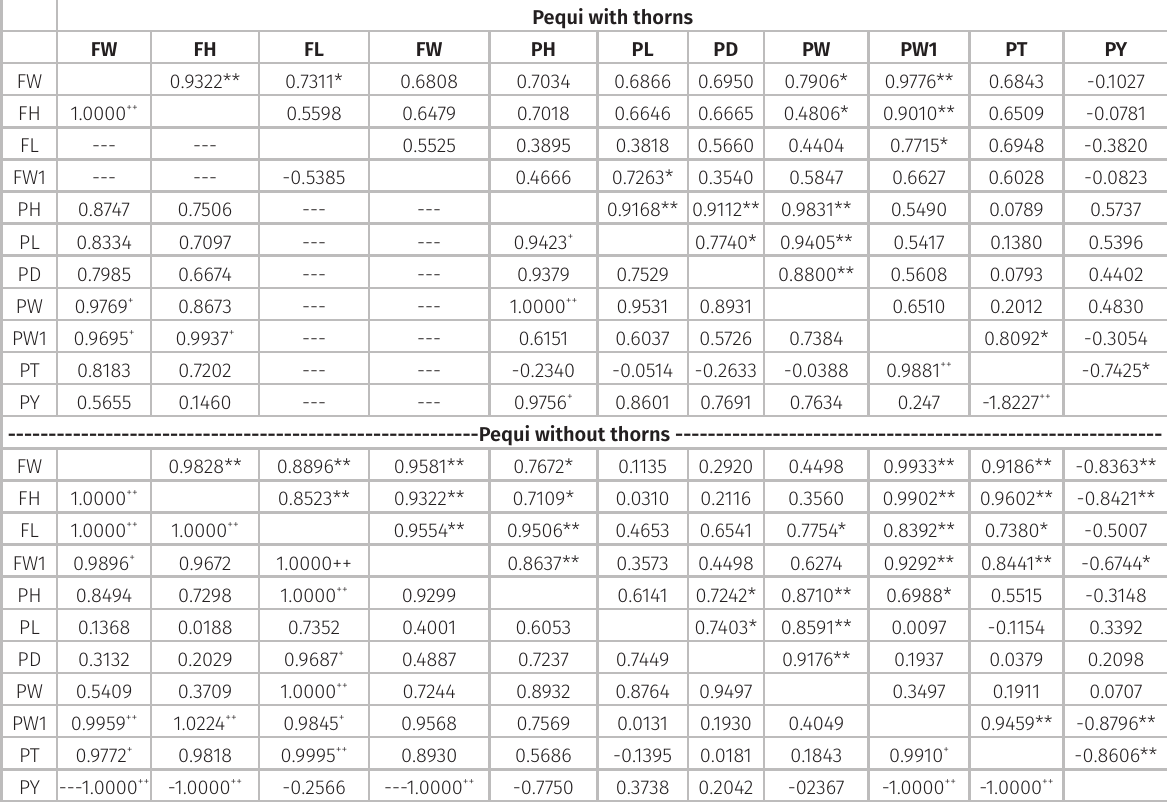
Table VI. Genetic correlations (below diagonal) and phenotypic correlations (above diagonal) between morphological characters of pequis with and without thorns in the endocarp, produced at Água Limpa Experimental Station – UFU, Uberlândia – MG, Brazil,